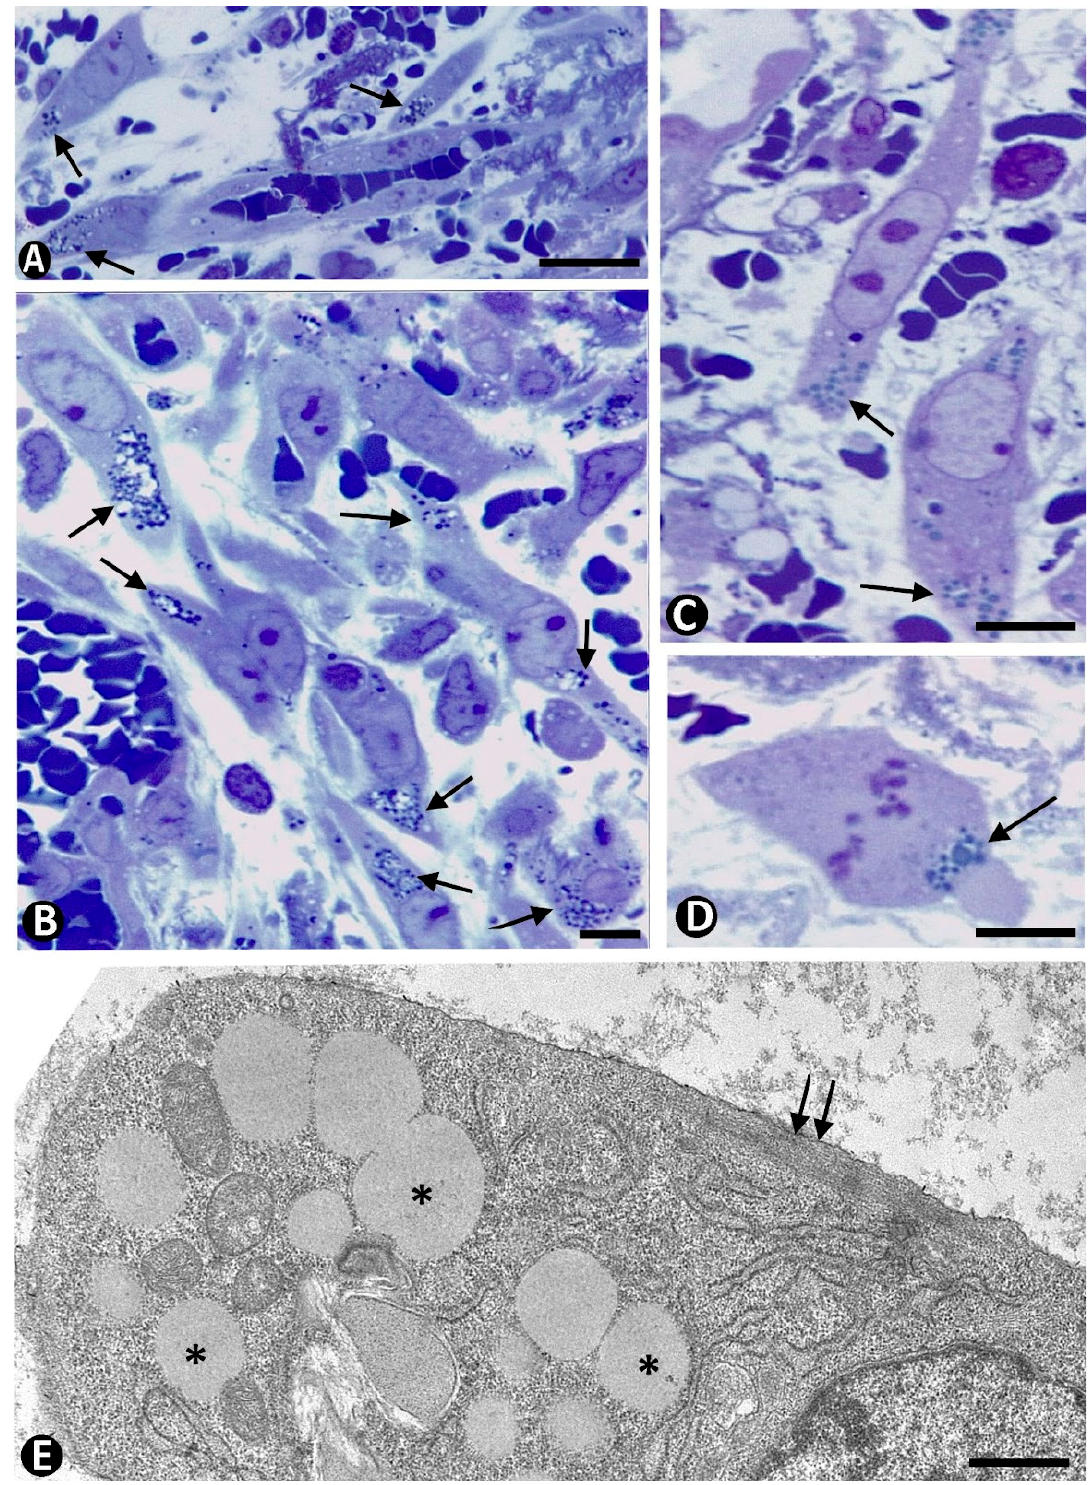
Figure 6. Presence of intracytoplasmic lipid droplets in some stromal cells (lipid-laden cells, lipid- interstitial cells, lipofibroblast-like cells). Note groups of lipid droplets in semithin sections ( A – D , arrows). One cell in mitosis ( D ) and the ultrastructural characteristics of a lipid-interstitial cell with lipid droplets (asterisks) and a small peripheral band of filaments with dense bands (double arrow). ( A – D ): Semithin sections. Toluidine blue staining. ( E ): Ultrathin section. Uranyl acetate and lead citrate. Bar: ( A ): 45 µm; ( B ): 12 µm; ( C , D ): 15 µm; ( E ): 0.8 µm.